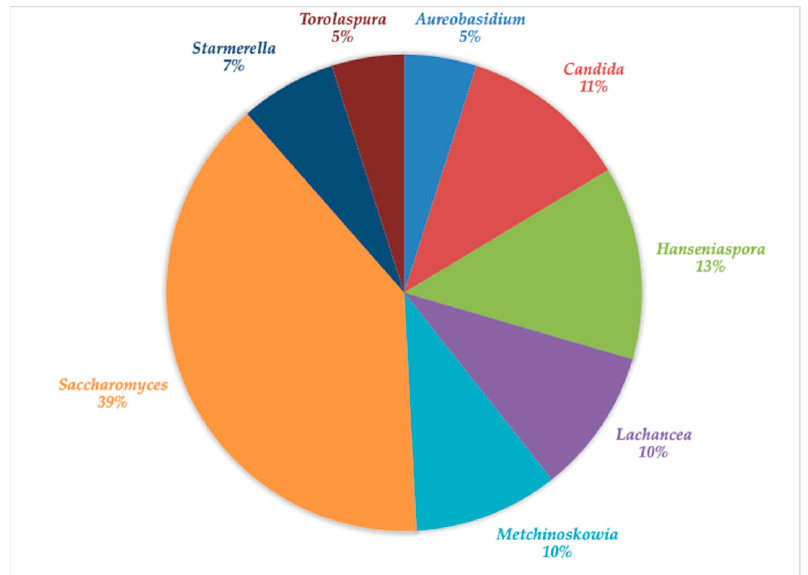
Figure 3. Estimated distribution of yeast species isolated from the spontaneous grape fermentations tested based on morphology. The colonies isolated were identified based on the 26S rRNA se ‐ quences.